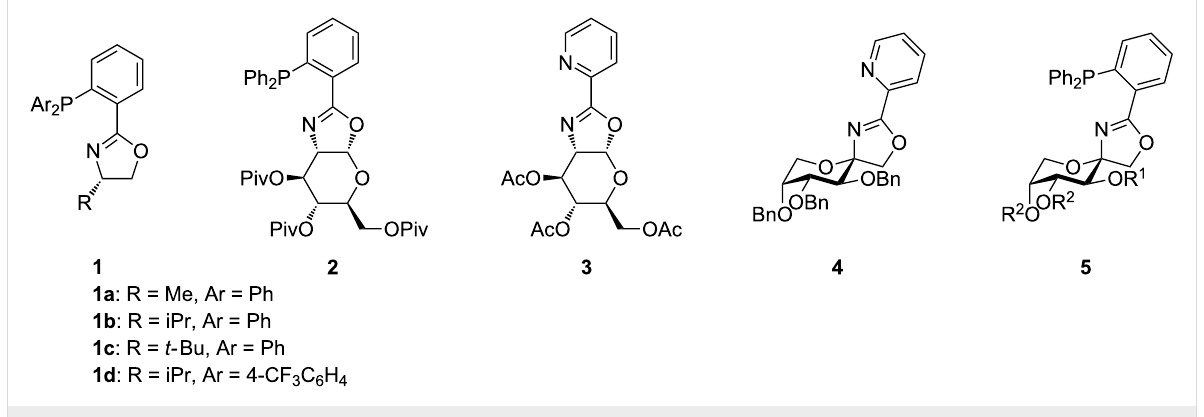
Figure 1: General structure of PHOX ligands 1 and structures of annulated glucosamine-based PHOX and PyOx ligands 2 and 3 and spiro-fused PyOx and PHOX ligands 4 and 5